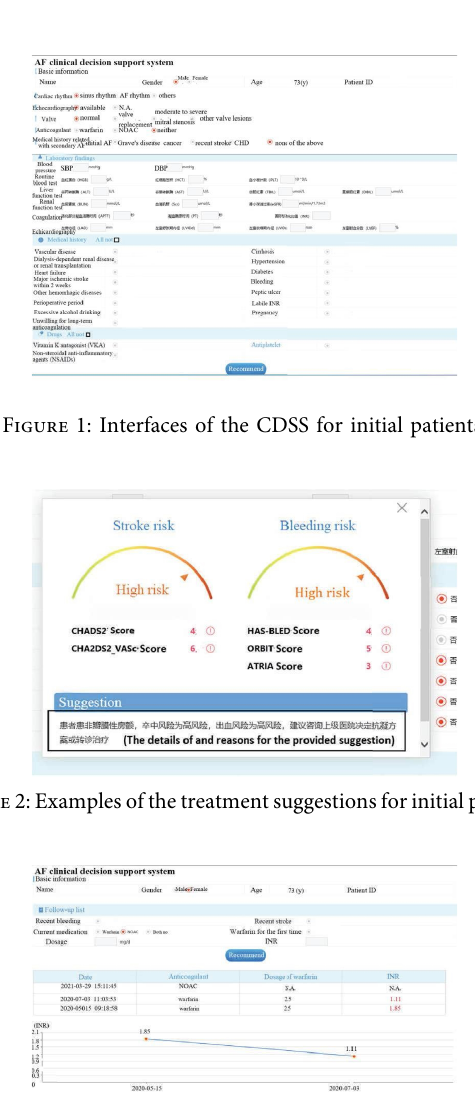
Figure 3: Interfaces of the CDSS for patient follow-up visits.